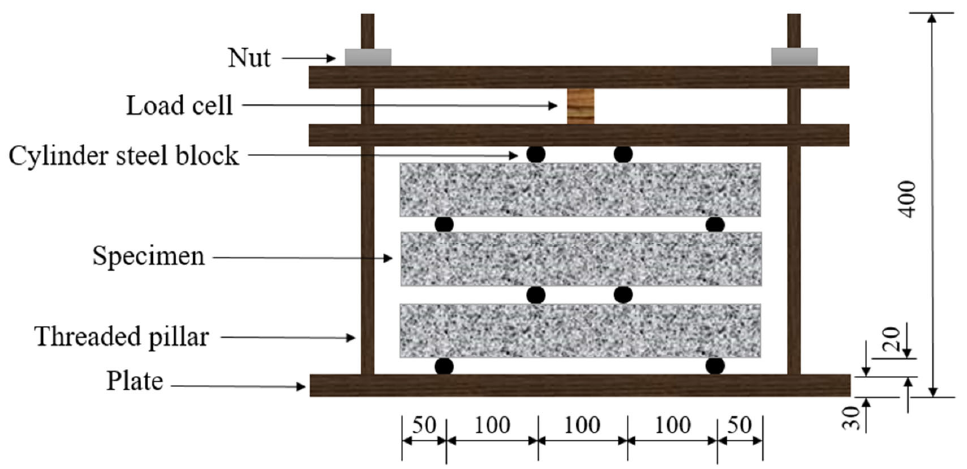
Figure 1. Schematic view of the apparatus for the sustained loading (unit: mm) (the full specimen is under accelerated carbonation).